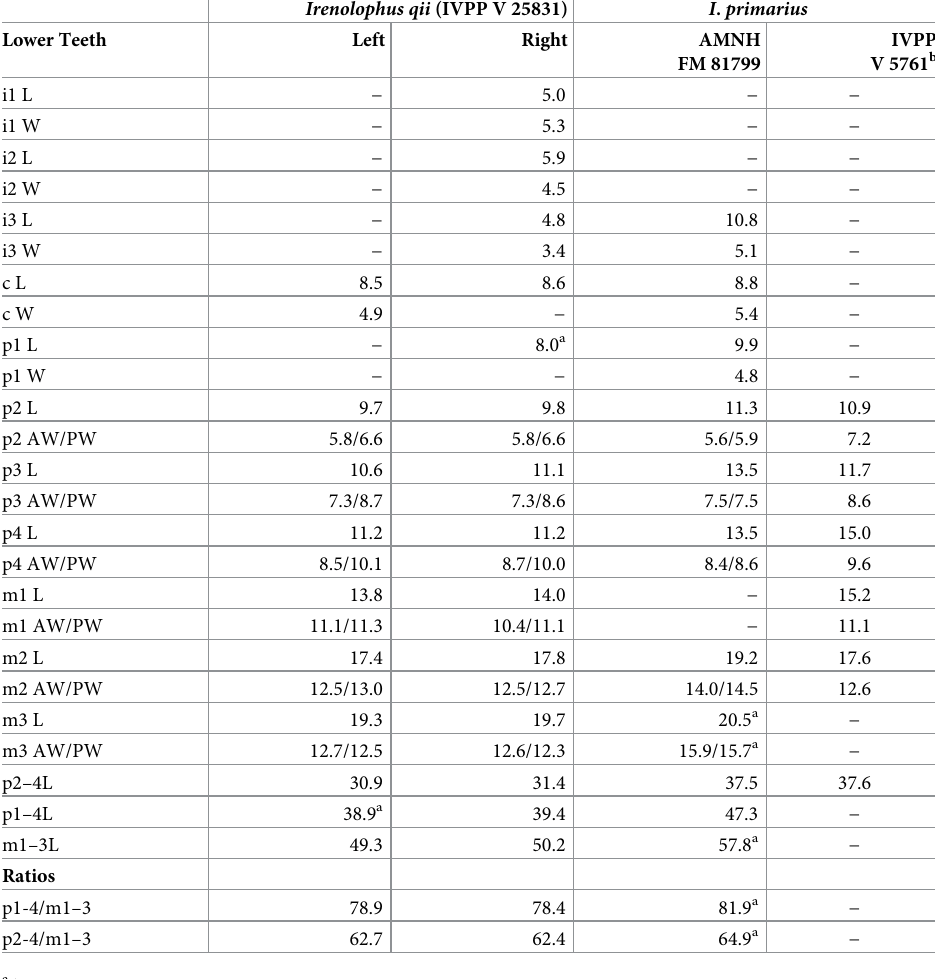
Table 3. Measurements of lower teeth of Irenolophus qii and I . primarius